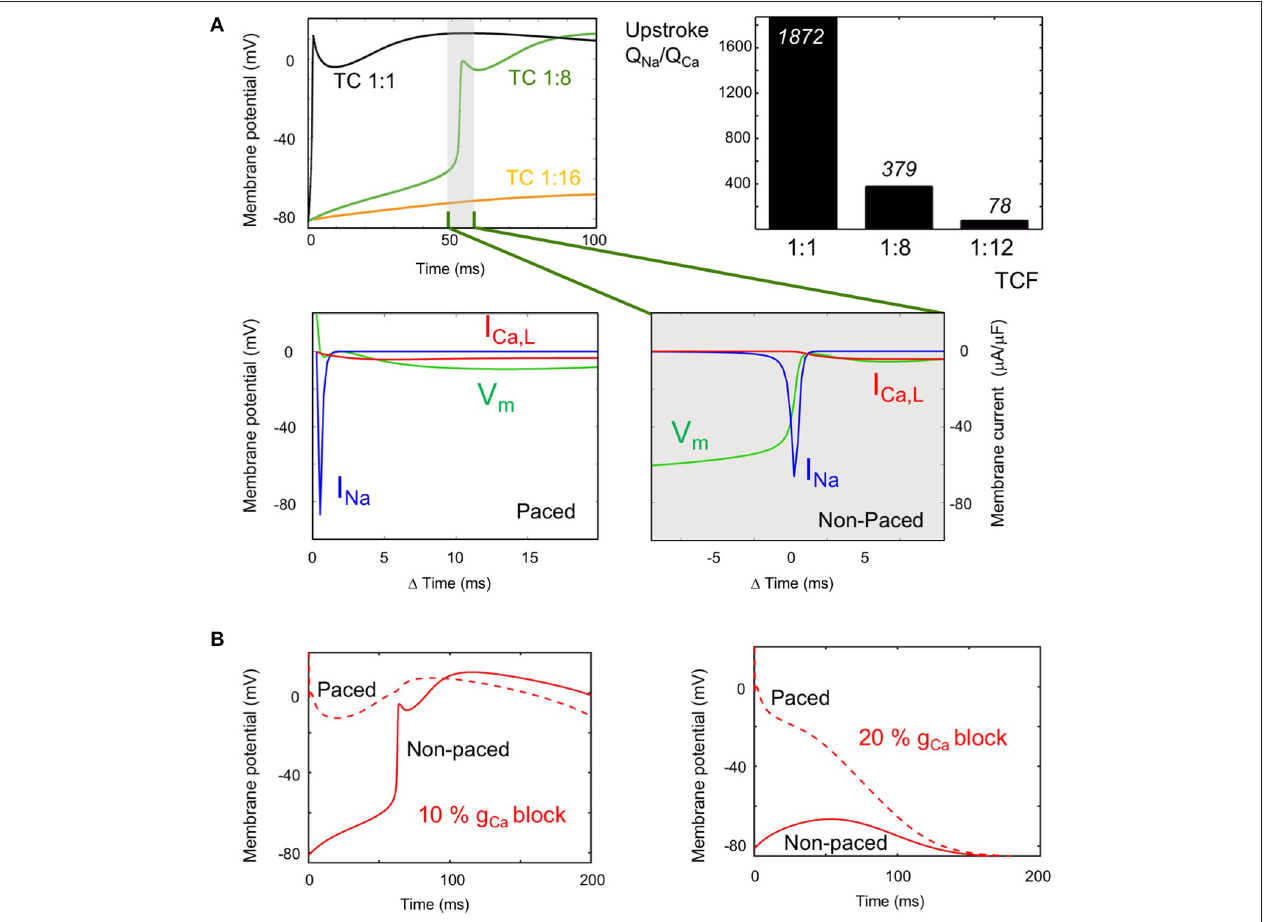
FIGURE 5 | Role of the sodium and calcium current (I Na and I Ca ) in transverse propagation. (A) I Na and I Ca during the upstroke at long TADs (LJC = 9:1). Top left: Action potentials (APs) in the non-paced strand, at the site directly opposing the pacing site, with TCF 1:1 (black), 1:8 (long TAD, green), and 1:16 (propagation failure, orange). Bottom row: V m (green), I Na (blue) and I Ca (red) during upstroke of the AP at a TCF of 1:8 are plotted for the paced strand (left panel) and the non-paced strand (right panel). The magnitude of I Na during the upstroke in the non-paced strand is several hundred times of that of I Ca . Top right panel: Calculated ratio of charge carried by the sodium and calcium current during the AP upstroke in the non-paced strand at various TCFs (LJC = 9:1). (B) Role of I Ca in transverse propagation (LJC = 9:1, TCF 1:8). APs are displayed for the paced strand (dashed line) and non-paced strand (solid line) for 10% I CaL blockade, where transverse propagation was successful (left panel) and for 20% I CaL blockade, where transverse conduction block occurred (right